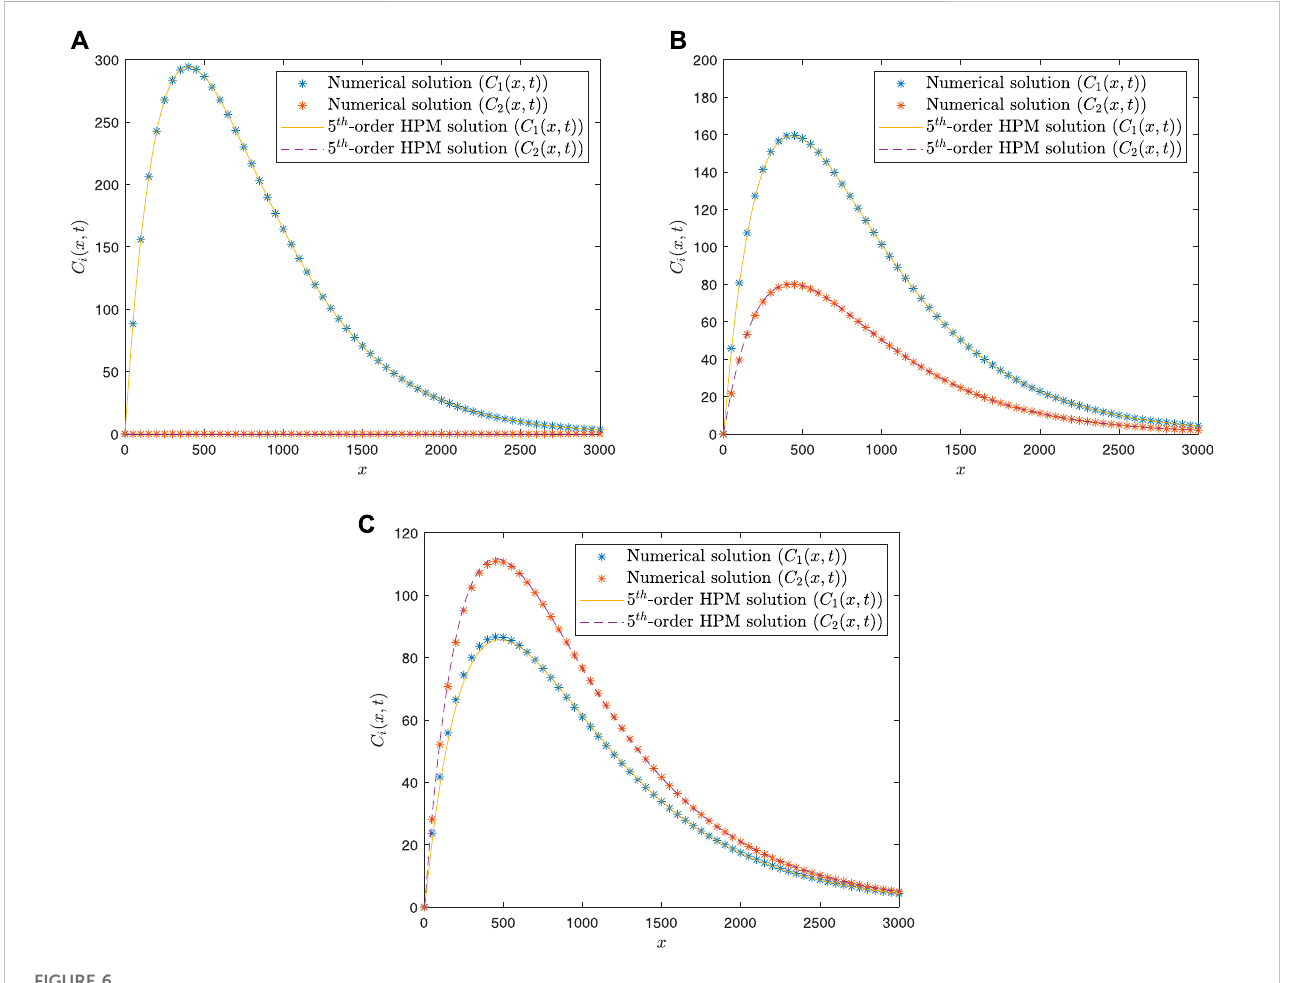
FIGURE 6 HPM-based pollutant concentrations versus distance for both species at: (A) t (cid:2) 0 h, (B) t (cid:2) 20 h, and (C) t (cid:2) 40